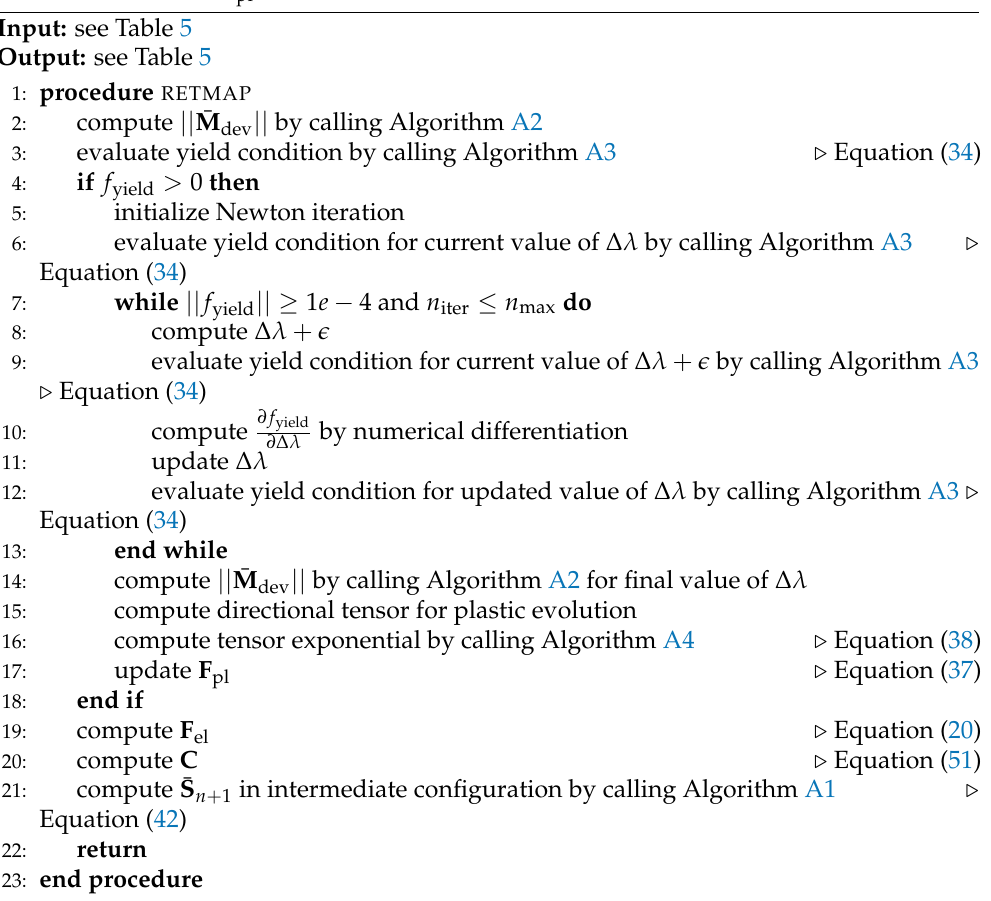
Algorithm 2 Return mapping algorithm implemented in COMSOL Multiphysics ® for the calculation of ¯ S and F pl .